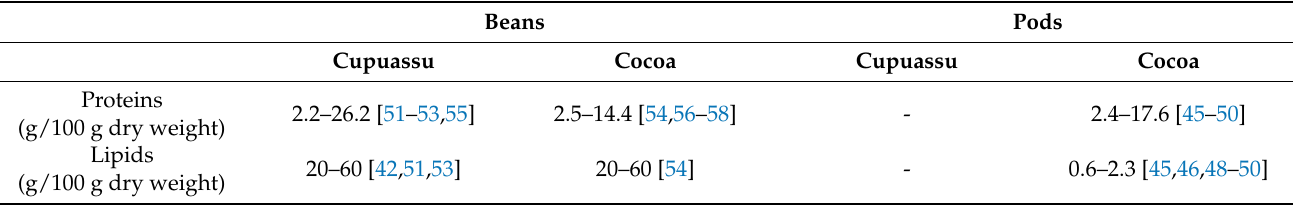
Table 2. Comparison of the chemical composition of cupuassu and cocoa. Beans